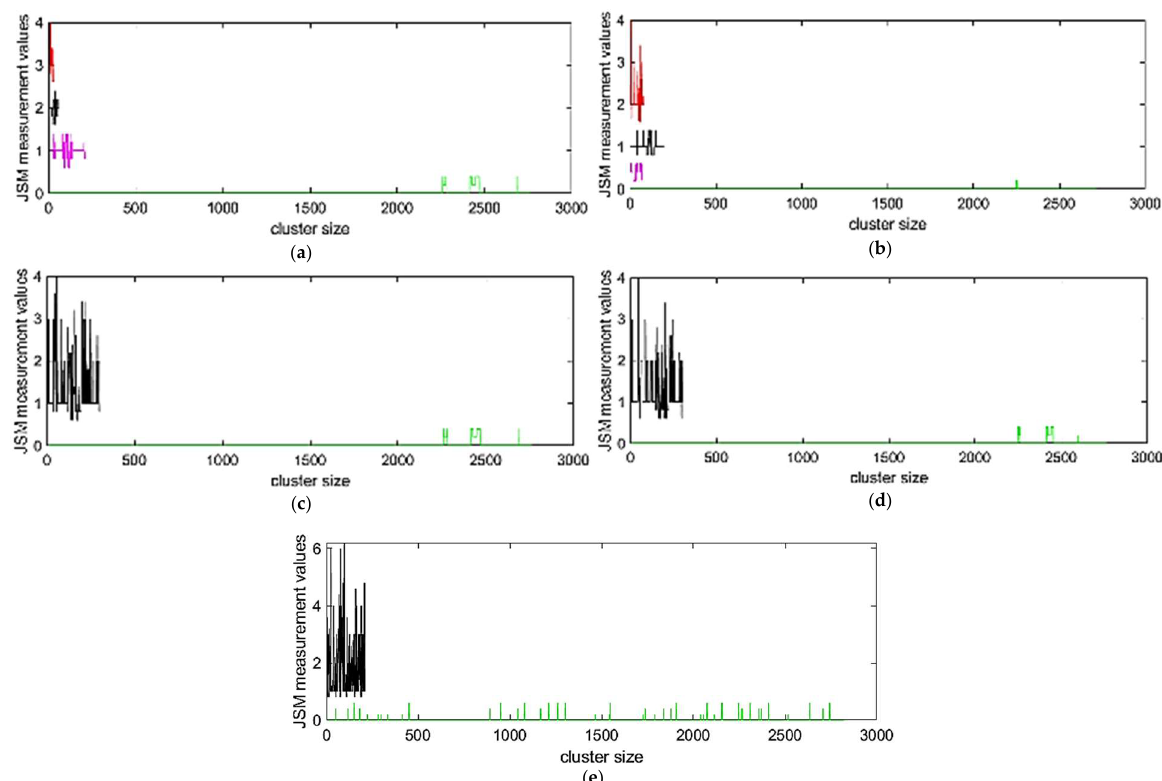
Figure 3. K-means clustering results of ( a ) left knee with Davies Bouldin index; ( b ) right knee with Davies Bouldin index; ( c ) left knee with 2 clusters; ( d ) right knee with 2 clusters; and ( e ) left and right knees combined with Davies Bouldin index. Table 4. Clustering results of each case with the Davies Bouldin index. Table 5. Clusters adopted in our study for each case. The best results are indicated with bold.